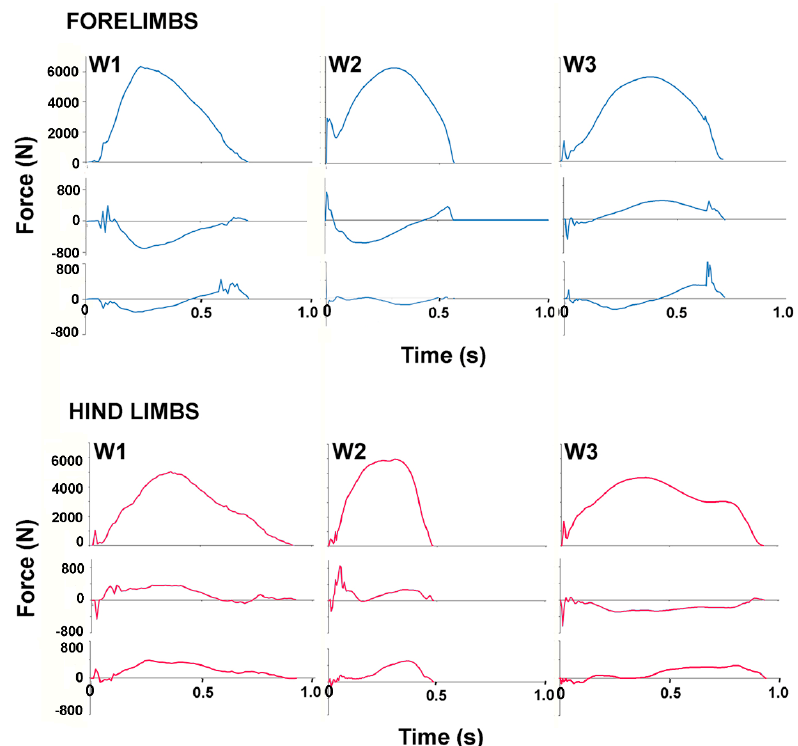
Figure 3. Ground reaction force traces for one example of a stance phase of each warmblood horse: left to right: W1, W2, W3. Vertical (above), longitudinal (middle) and transverse (below) forces for forelimbs (upper panel) and hindlimbs (lower panel). Table 2. Significant ( p < 0.05) Bonferroni-adjusted, between horse comparisons of combined fore and hindlimb GRF variables (A–F). A: stance duration, B: peak GRFv, C: time of peak GRFv, D: vertical impulse, E: time of peak GRFbr, F: peak GRFmed. Post hoc testing not performed for peak GRFpr, time of peak GRFpr and peak GRFlat, due to insufficient data from at least one horse.